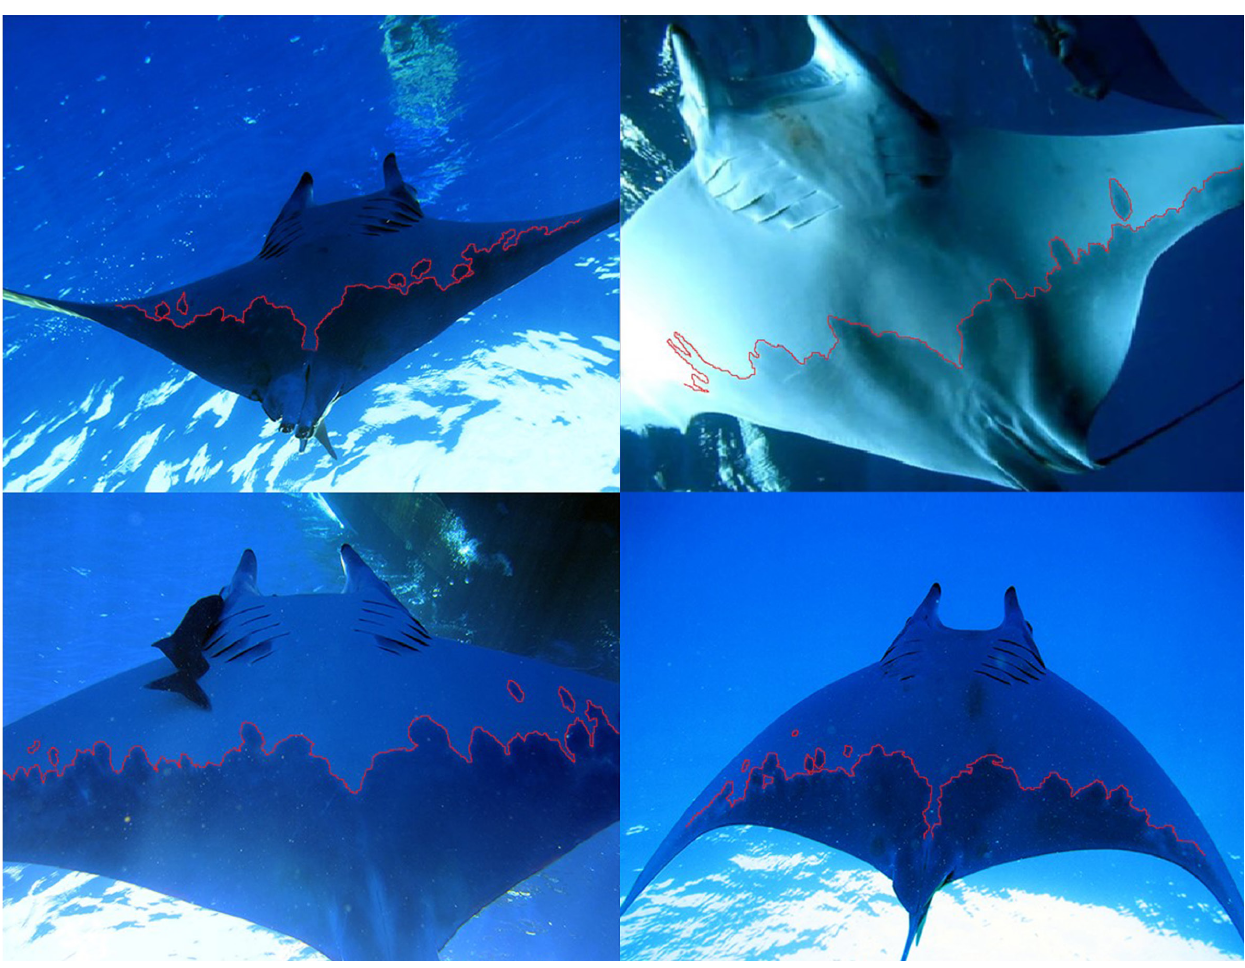
FIGURE 2 | Spot patterns used for photo identification of Mobula tarapacana in the Saint Peter and Saint Paul Archipelago